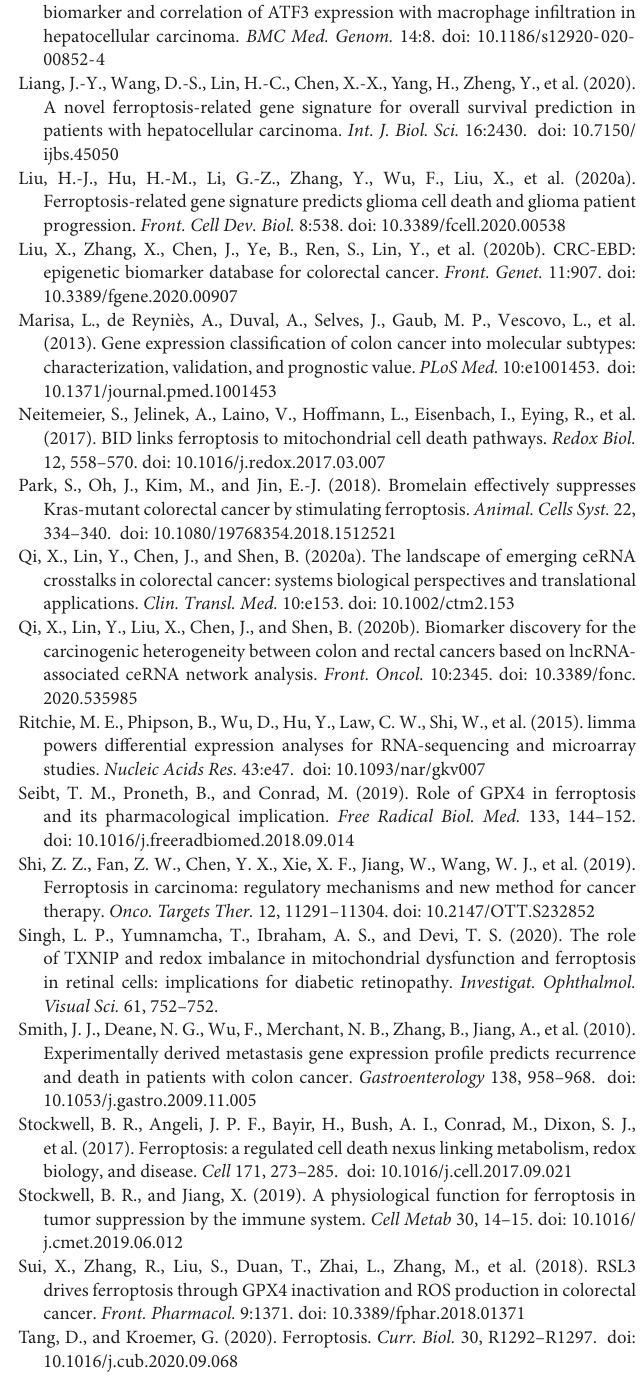
Supplementary Figure 4 | Validation of the FRG prognostic signature in the TCGA-COAD dataset. (A) Kaplan-Meier plot for overall survival of CC patients in high- and low-risk groups. (B) Time-dependent ROC curves for the prognostic performance of the FRG signature. It should be noted that the VLDLR gene was filtered out from the signature during Kaplan-Meier survival curve analysis and time-dependent ROC curve analysis due to its low expression level in the TCGA-COAD dataset.